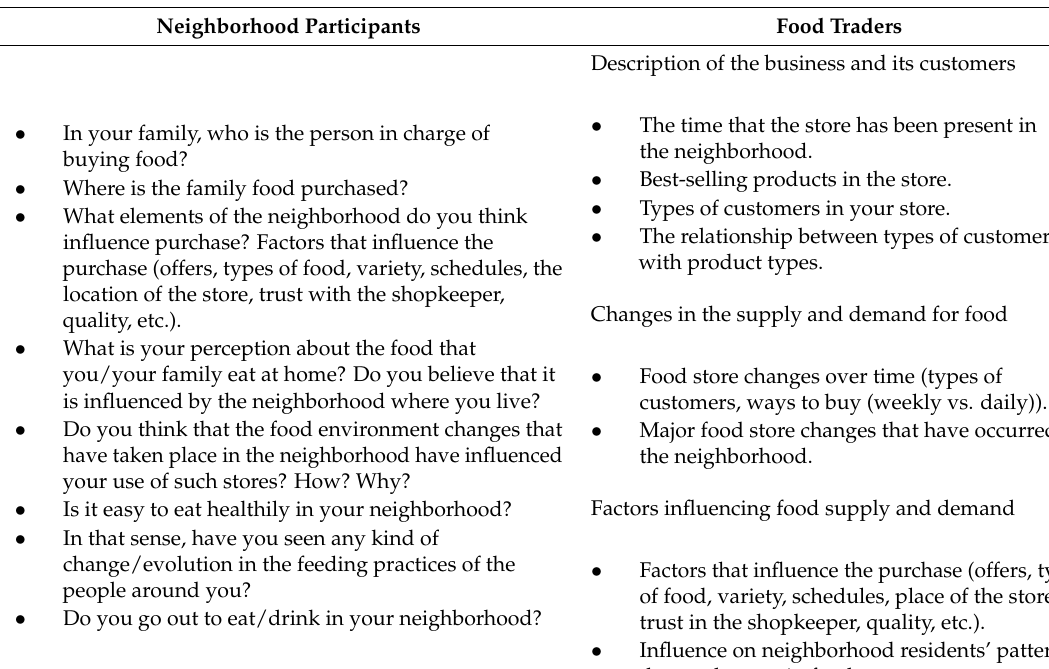
Table 2. Neighborhood participants’ and food traders’ interview topic